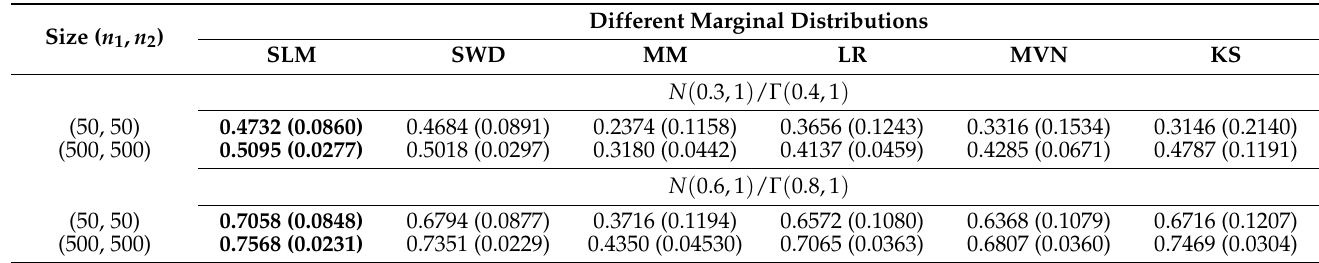
Table 15. Non-normal distributions: Different marginal distributions. Validation. Different Marginal Distributions Size ( n 1 , n 2 )